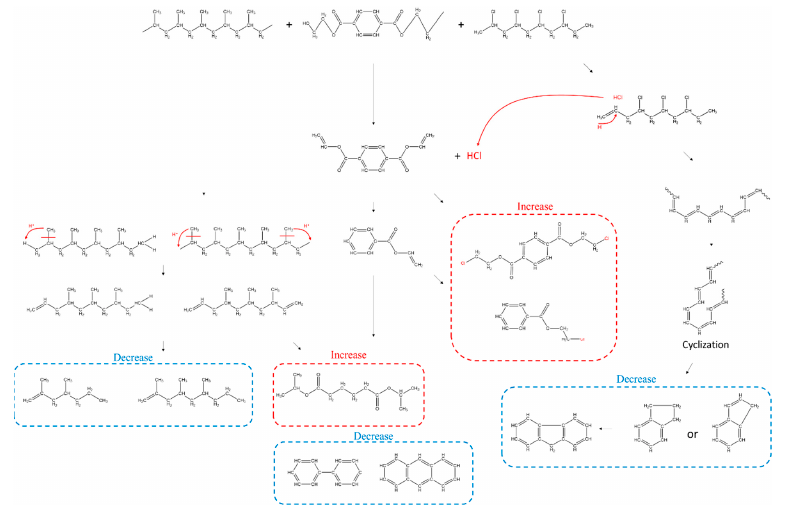
Figure 6. Overview of the occurrence of some pyrolytic compounds inferred from the pyrolysis process of MP.